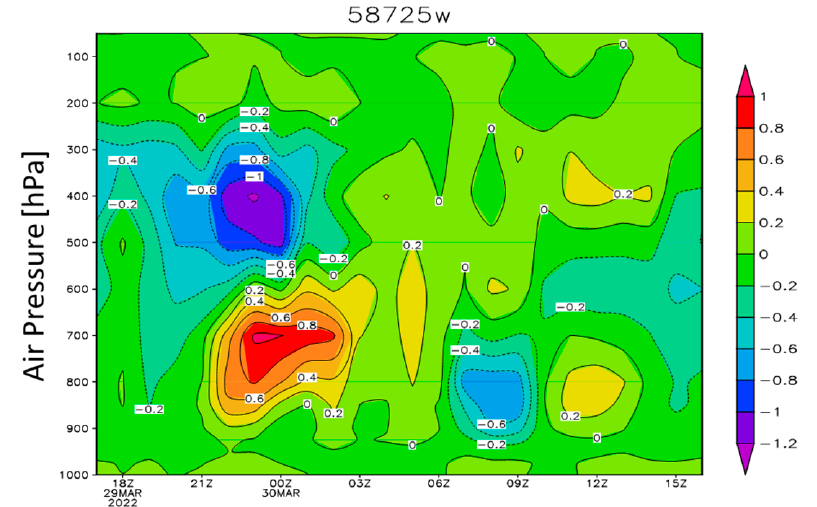
Figure 9. The distribution of vertical velocity (shading, units: Pa ∙ s − 1 ) and wind divergence (black contours, units: 10 − 5 ∙ s − 1 ) at the Shaowu station during 29–30 May 2022 as a function of hours (data from ERA-5).